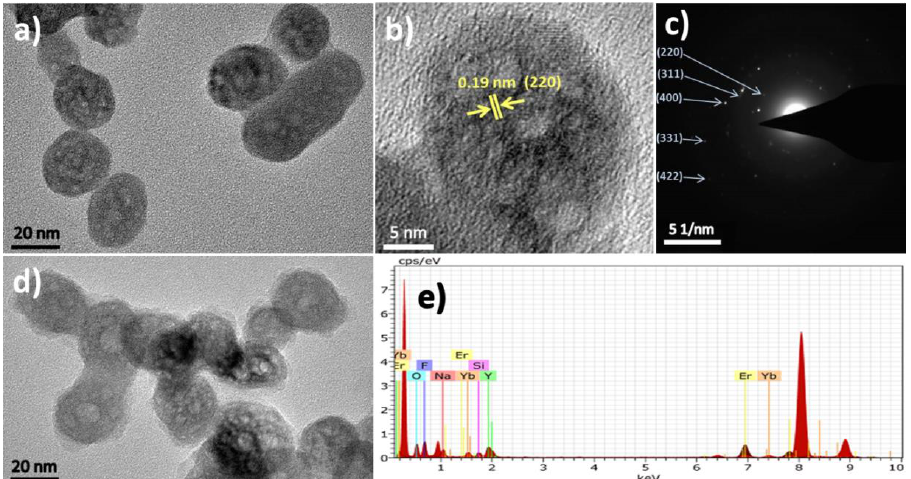
Figure 2. Transmission electron microscope (TEM) image of ( a ) NaYF 4 :Yb/Er UCNC, ( b ) High-resolution TEM image of NaYF 4 :Yb/Er UCNC, ( c ) selected area electron diffraction (SAED) patterns of NaYF 4 :Yb/Er UCNC, ( d ) UCNC@SiO 2 , and ( e ) energy dispersive X-ray analysis (EDAX) of UCNC@SiO 2